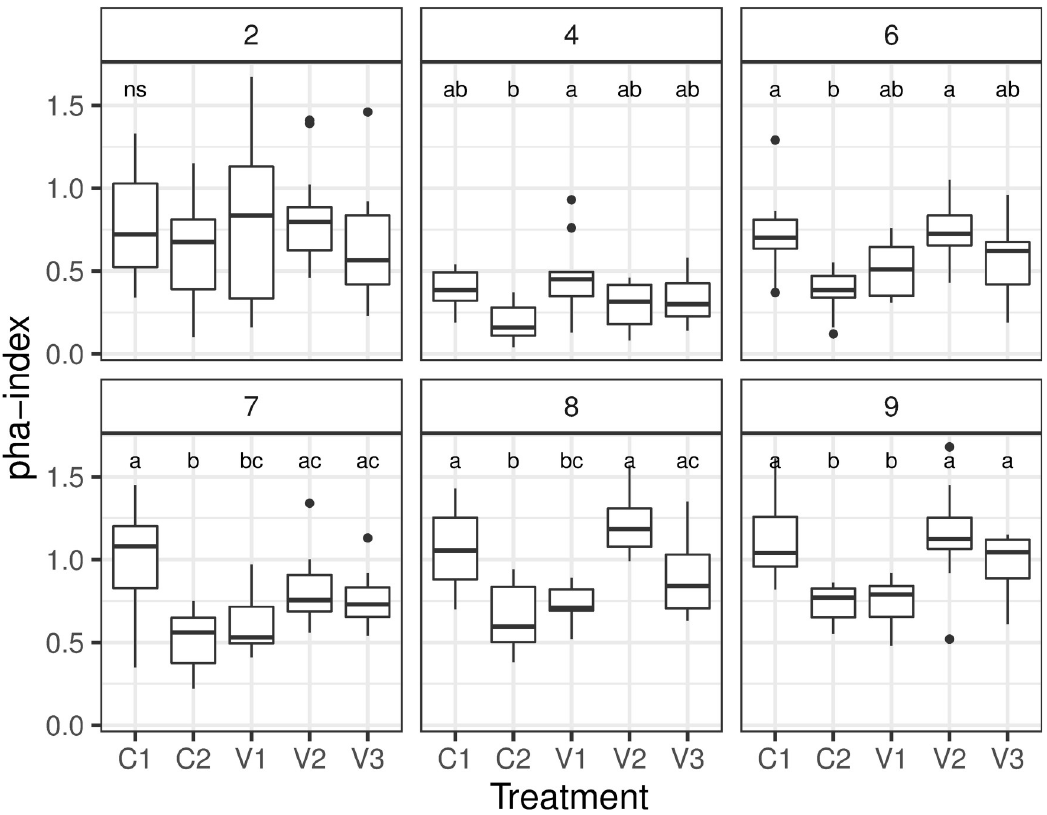
Fig 2. Boxplot presenting the results of the PHA test over the nine weeks of the study. Small letters indicate significant differences between groups within weeks with 2,4,6,7,8,9 indicating the age of the chickens in weeks.